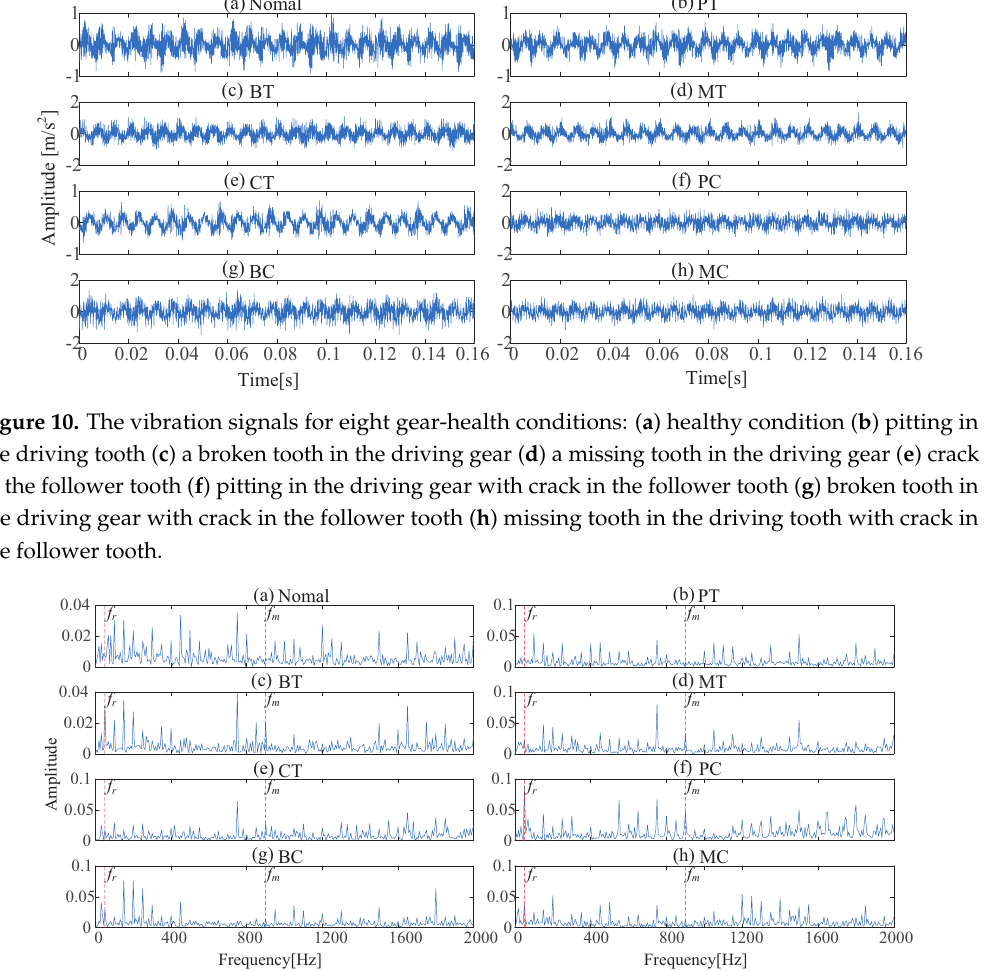
Figure 11. Envelope spectra for eight gear-health conditions: ( a ) healthy condition ( b ) pitting in the driving tooth ( c ) a broken tooth in the driving gear ( d ) a missing tooth in the driving gear ( e ) crack in the follower tooth ( f ) pitting in the driving gear with crack in the follower tooth ( g ) broken tooth in the driving gear with crack in the follower tooth ( h ) missing tooth in the driving tooth with crack in the follower tooth.